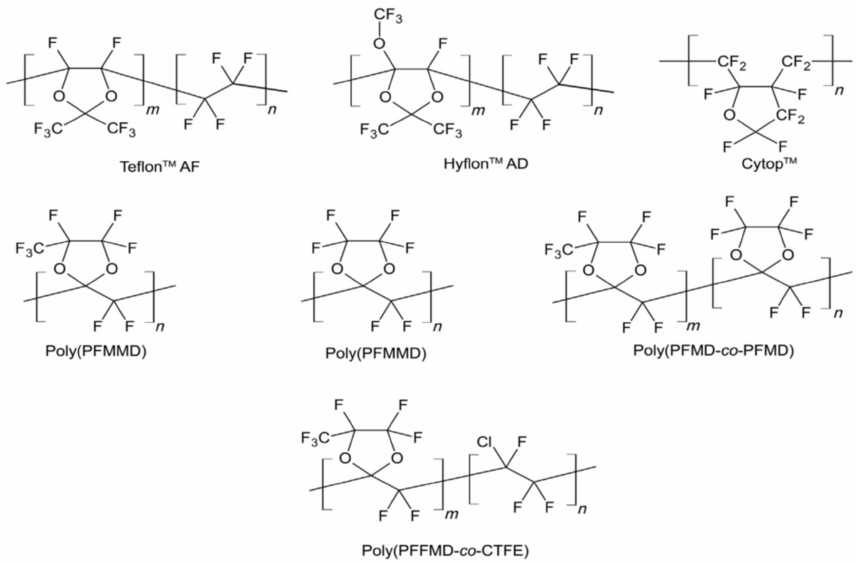
Figure 2. Perfluoro-polymers structures. Adapted from